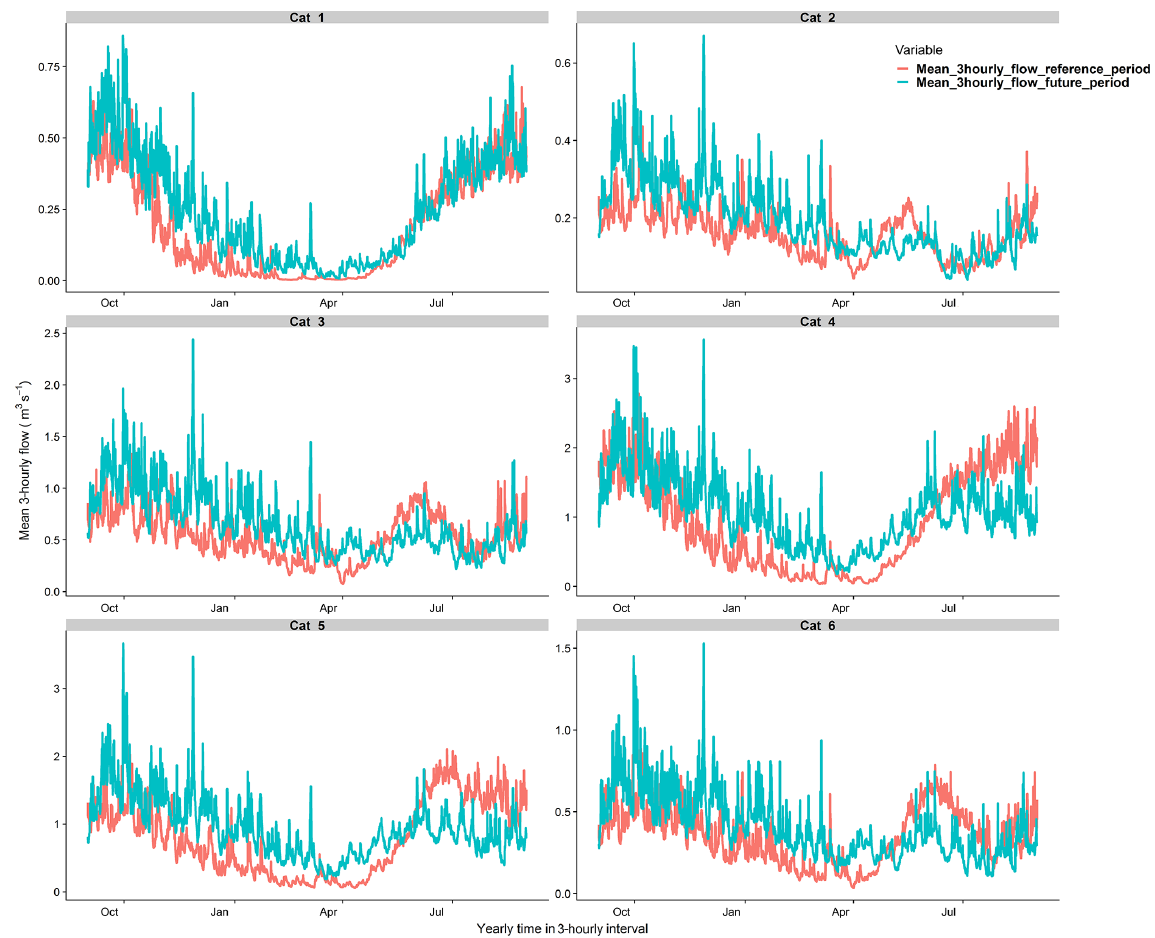
Figure 3. Yearly mean 3-hourly hydrographs of the study catchments for the reference and future